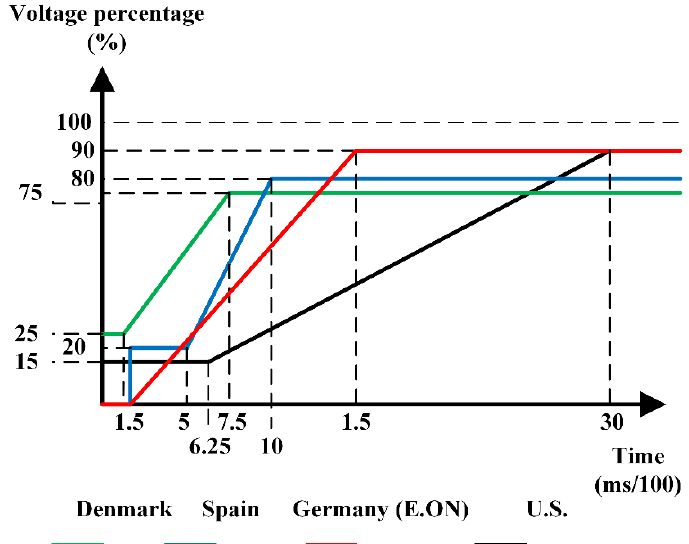
Figure 1. The grid code requirement for the fault ride-through of the wind turbine in the different countries [4]. Adapted with permission from [4], Copyright Publisher, 2015.